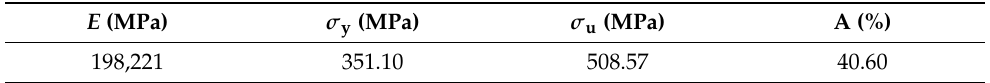
Figure 1. Schematic diagram of the arch bridge: ( a ) deck cross-section at the center span; ( b ) plan view; ( c ) elevation view; ( d ) structural details of orthotropic deck (unit: mm). Table 1. Mechanical properties of Q345C